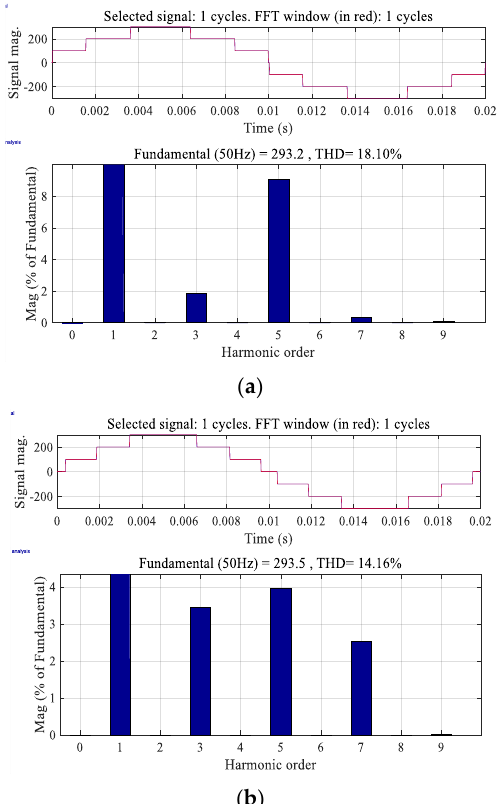
Figure 12. FFT analysis for 9th order harmonic elimination at 𝑚 = 2.934 using ( a ) the conventional technique and ( b ) the proposed technique.